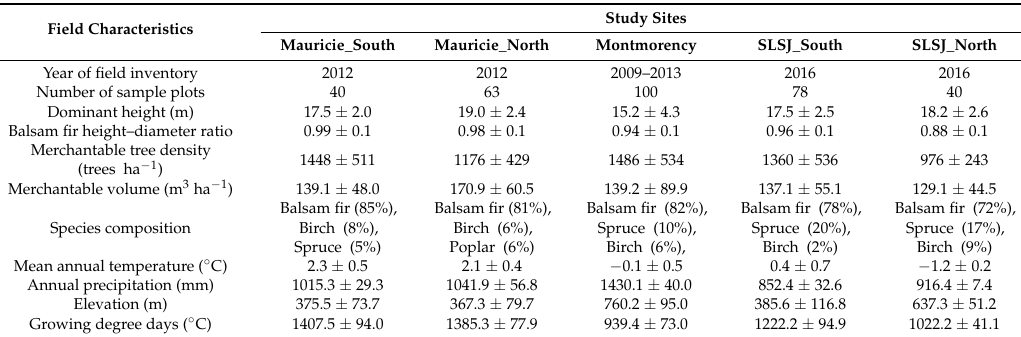
Table 1. Summary of the field data a